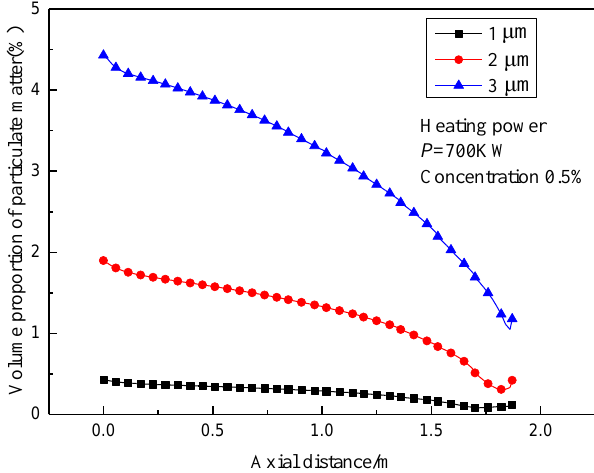
Figure 13. Particle concentration distribution in the heating section under different particle diameters.